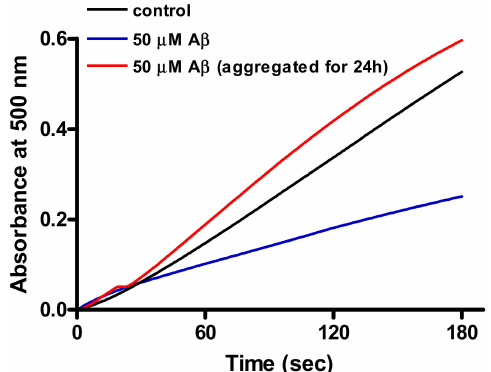
Figure 7. E ff ect of di ff erent aggregation states on the reaction rate of DHR oxidation by CO 3 •− . Freshly dissolved A β 25-35 (blue line) and aggregated A β 25-35 (red line) after 24 h incubation. A β 25-35 (50 µ M final concentration) was added to a solution containing 25 µ M DHR, 31 µ M SOD, 0.1 mM DTPA, and 25 mM sodium bicarbonate in 0.2 M phosphate bu ff er, pH 7.4. Reaction was started by the addition of 1 mM H 2 O 2 . DHR oxidation rate was measured spectrophotometrically at 500